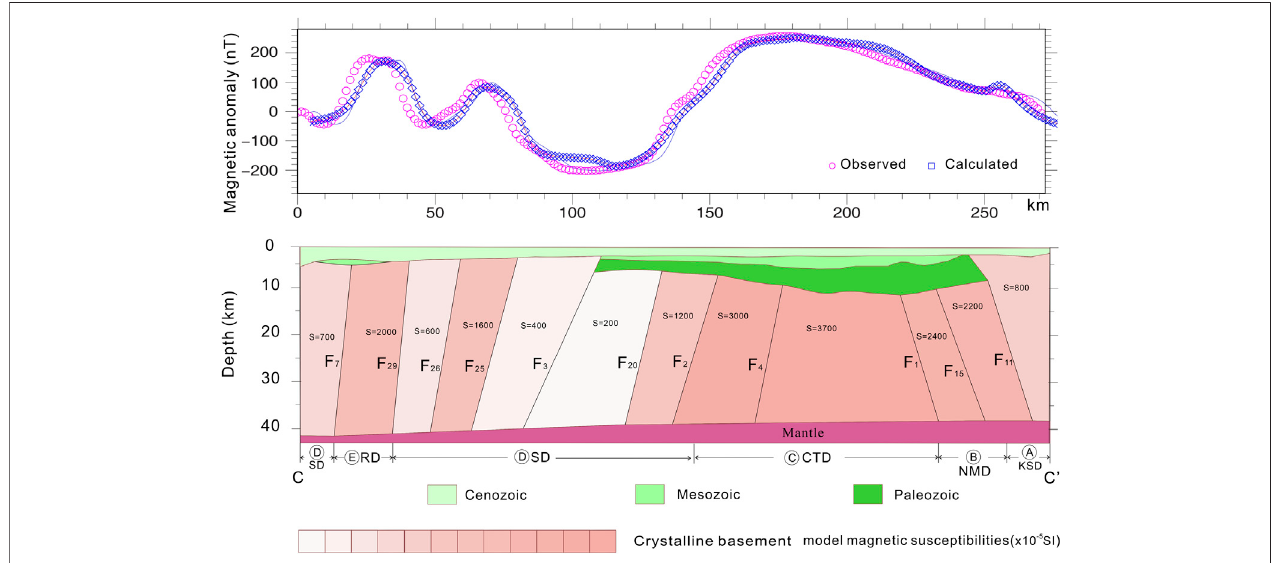
FIGURE 9 | Pro fi le CC ′ for magnetic forward modeling, pro fi le location showed in Figure 3A . See Figure 7 for other fi gure descriptions.